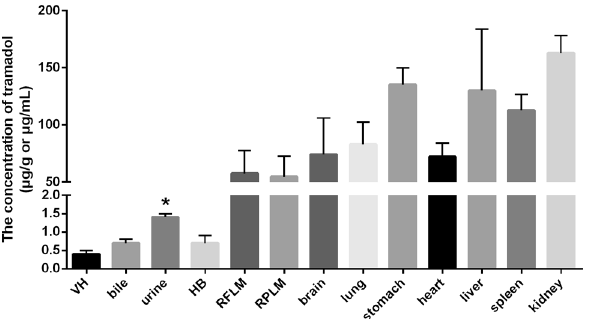
Figure 1. Postmortem distribution of tramadol in rabbits dying of poisoning. VH vitreous humor, HB heart blood, RFLM right forelimb muscles, RPLM right posterior limb muscles. Data was represented by mean ± standard deviation. * P < 0.05, compared with the concentrations of tramadol in other